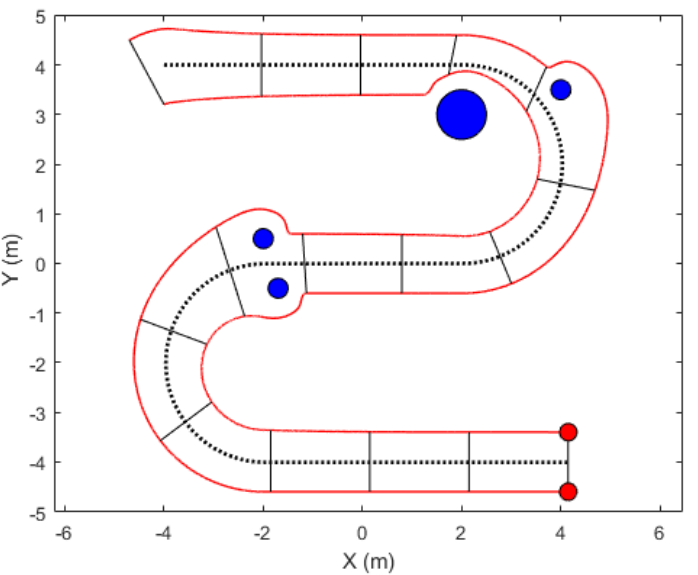
Figure 15. The formation tracking performance for two